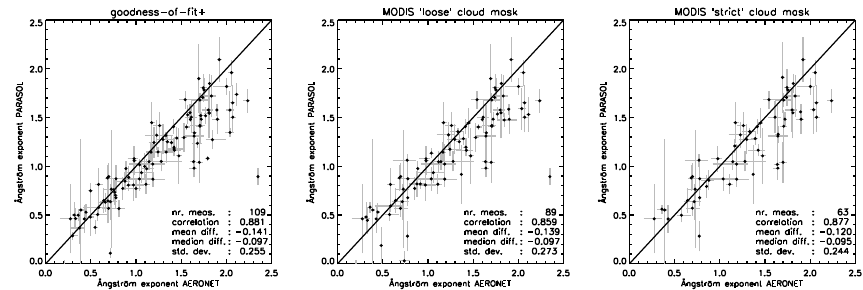
Figure 11. A comparison of the ÅEs retrieved from the medium-resolution PARASOL observations vs. those retrieved by AERONET (level 2.0) for the three different cloud screenings. The black line shows the 1 : 1 ratio.